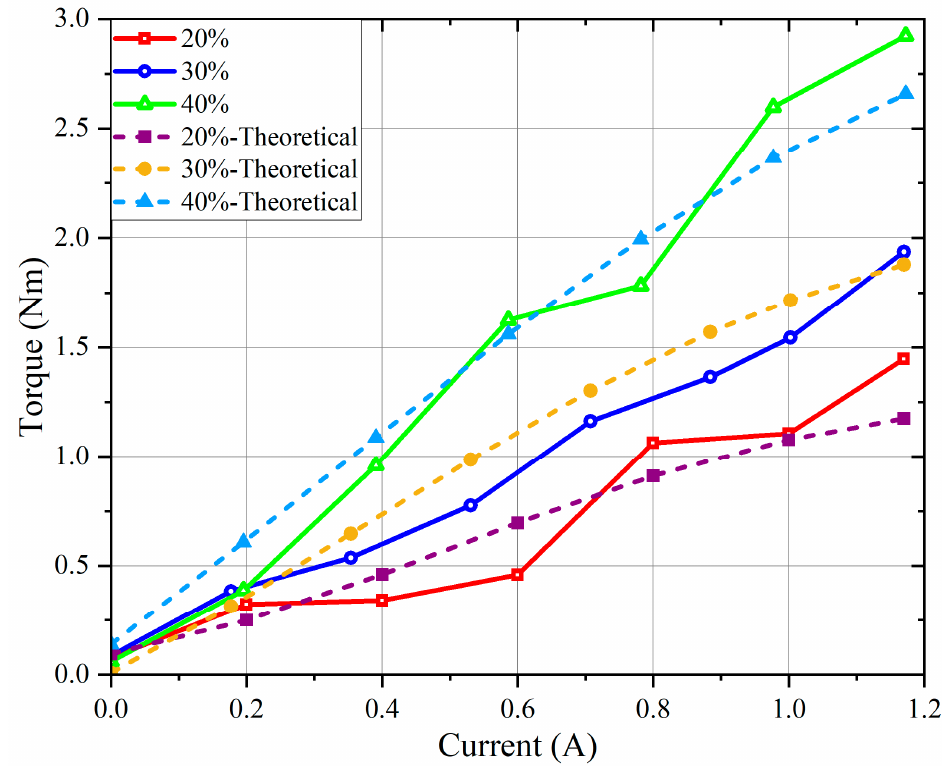
Figure 6. Torque–current curves of MRGs with different mass fractions: the three curves from top to bottom represent MRGs with iron powder percentages of 40%, 30%, and 20%. The current varies from 0 A to nearly 1.2 A.